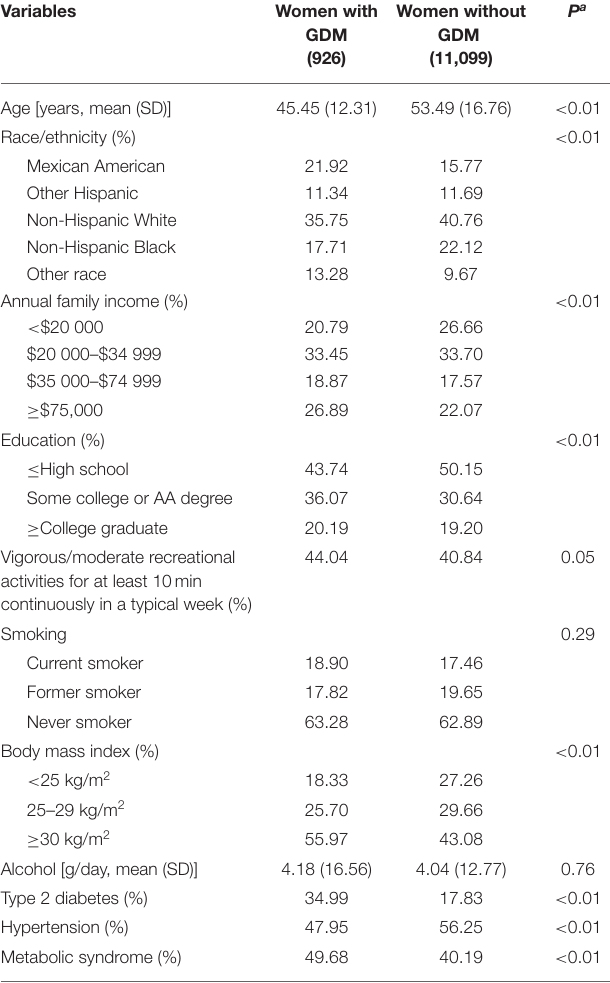
TABLE 1 | Characteristics of the 2007–2018 NHANES adults according to the presence or absence of a history of gestational diabetes mellitus (GDM).